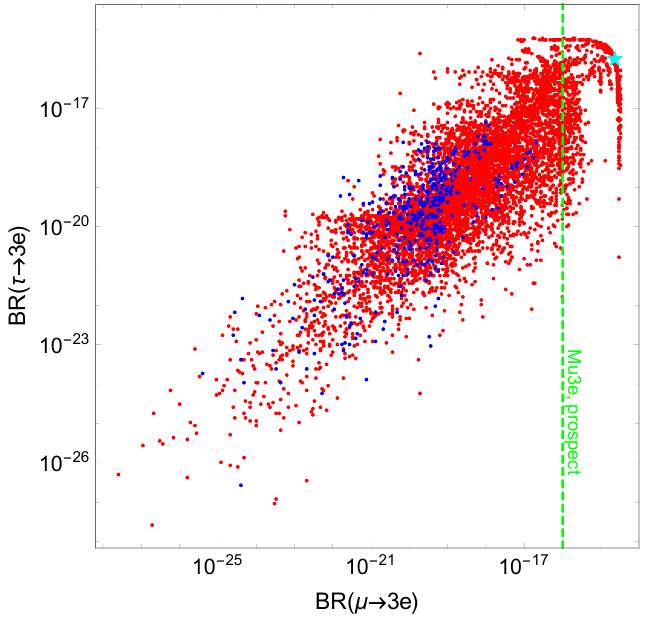
within 2 σ , while the blue ones K